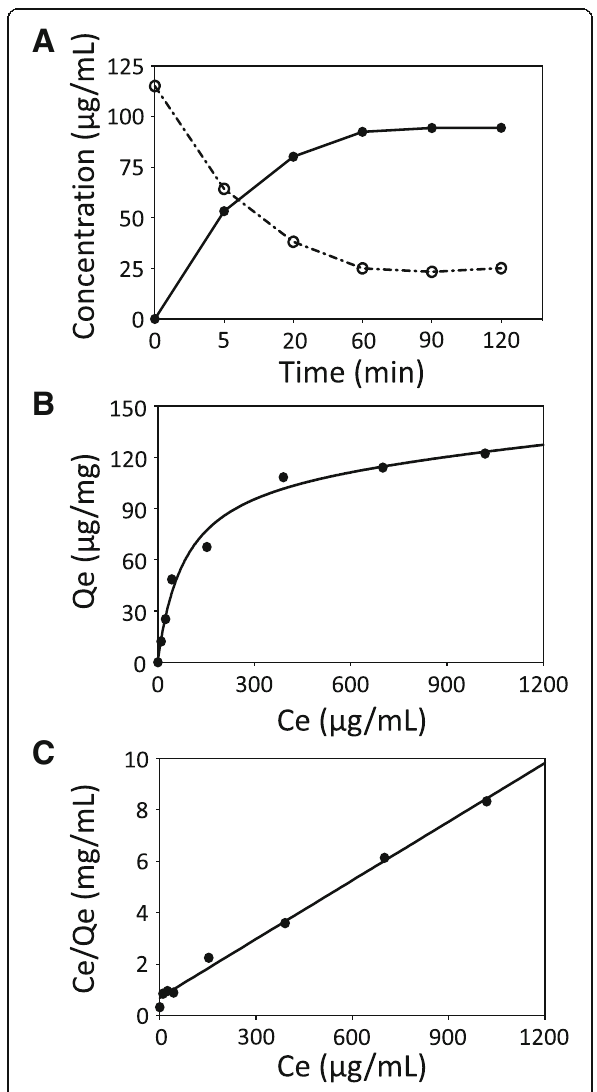
Fig. 3 Adsorption of molybdenum by synthetic melanin. Levels of melanin-bound molybdenum (closed circle) and unbound molybdenum (open circle) molybdenum incubated in water for the indicated time ( a ) and equilibrium data ( b ) and Langmuir isotherm ( c ) for adsorption of molybdenum by synthetic melanin are presented. Consistent results were obtained by the experiment independently repeated three times, and representative result results are presented. Qe ( μ g/mg), amount of molybdenum adsorbed by melanin at equilibrium; Ce ( μ g/ml), concentration of molybdenum in solution at equilibrium; Qmax (131 μ g/mg), maximum adsorption